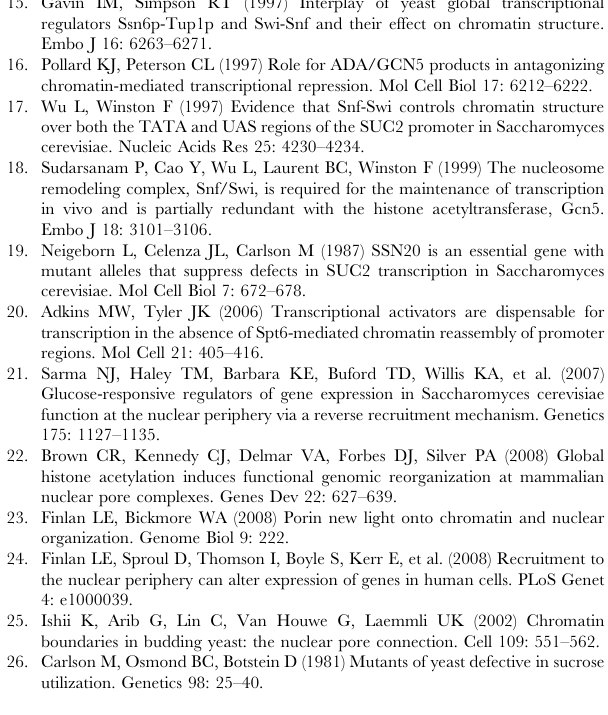
panel shows the DIC images of the cells corresponding to the left panel. Figure S2 Exponential loss of SUC2 repression upon depletion of Mig1 from the perinuclear compartment. Perinuclear, lumenal, and total levels of nuclear Mig1-GFP were determined by QFPD analysis (y-axis); percent SUC2 repression (x- axis) reflects the increase in invertase expression in nup mutants relative to wild type (see Fig. 4 and Table 2). The wild type data points are indicated by arrows. Figure S3 Binding of primers to the IP DNA is linear. In wild type (WT) cells, Mig1 binds to the SUC2 promoter in the presence of glucose (R; repressed conditions); in snf1 D cells Mig1 binds to the SUC2 promoter in both the presence and absence of glucose (D; derepressed conditions). Addition of increasing amounts of immunoprecipitated chromatin as template DNA (1X, 2X, 3X) produces a corresponding increase in the amount of PCR product. Table S1 Yeast strains and plasmids used in this study. Strains are isogenic to BY263.